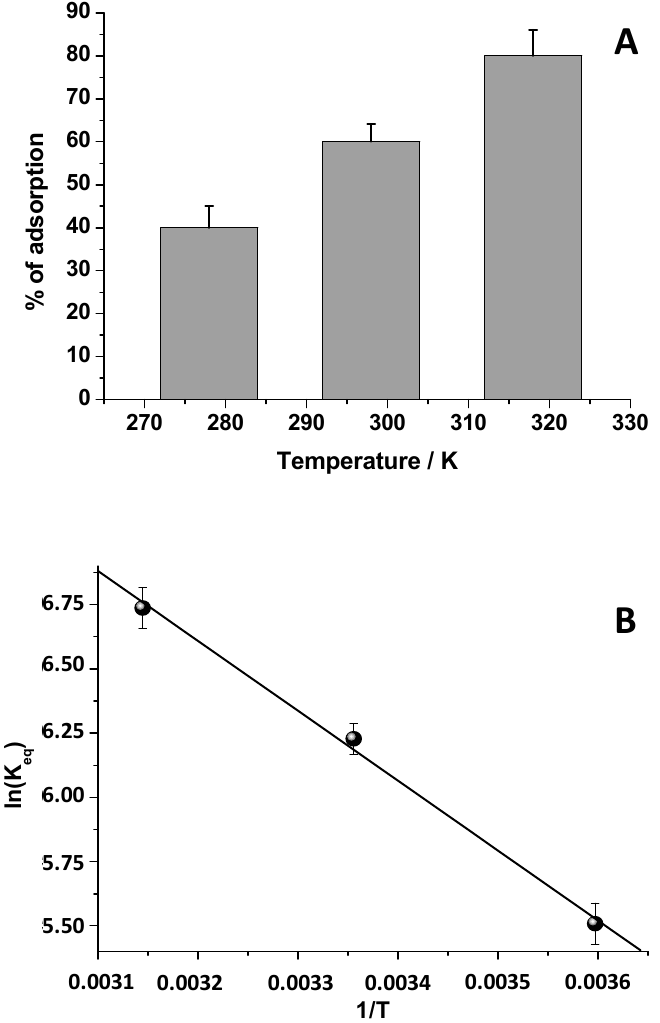
Figure 6. ( A ) DCF adsorbed the percentage at different temperature values (adopting as contact time 120 min). ( B ) lnK eq vs 1/T. In particular, the K eq represents the equilibrium constant at the selected temperature value.